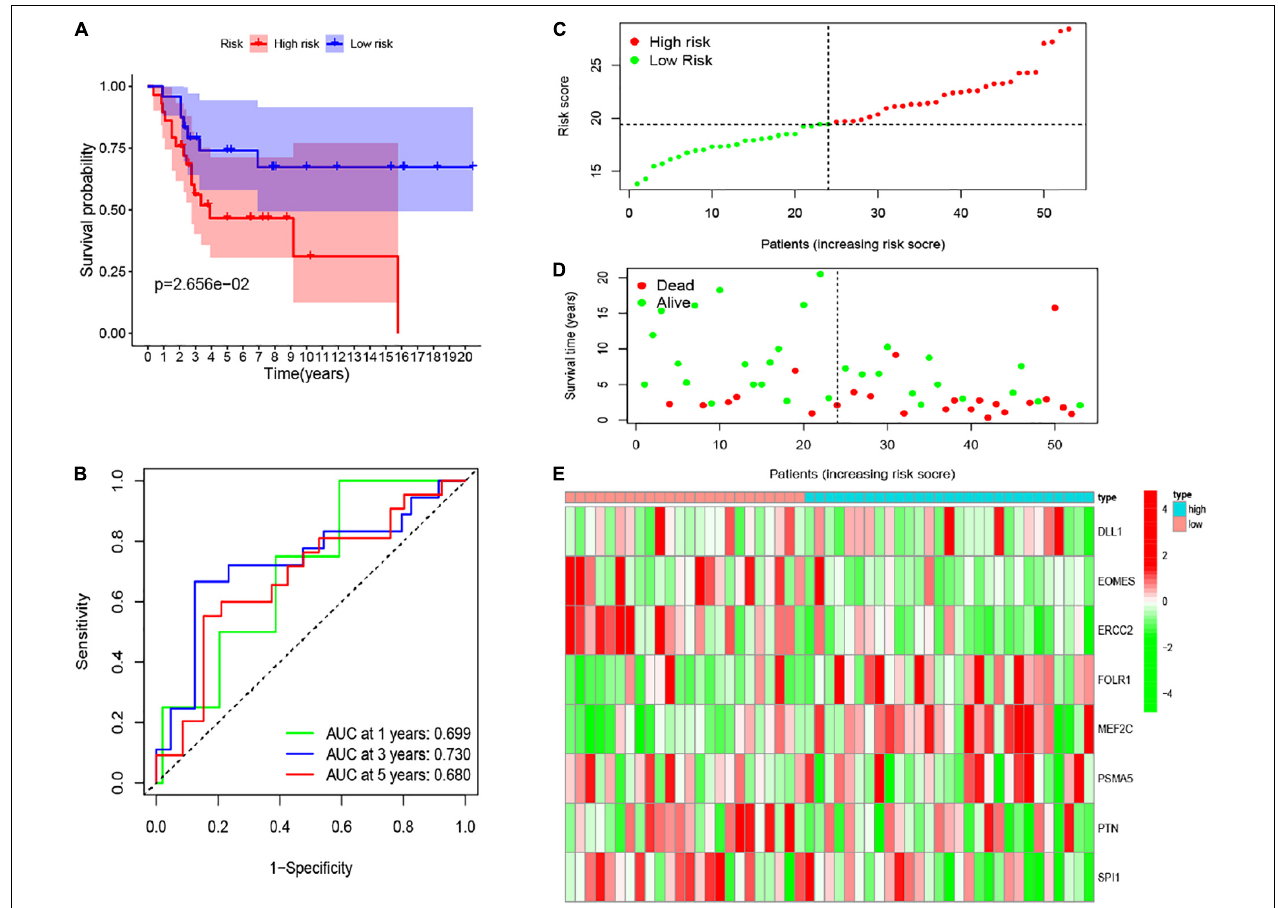
FIGURE 7 | (A) The K-M curve of the eight-gene signature in the GEO test cohort. (B) The ROC curve and AUC value of the eight-gene signature in the GEO set. (C–E) The risk score, survival time, and status as well as the expression of the eight genes in the GEO set.